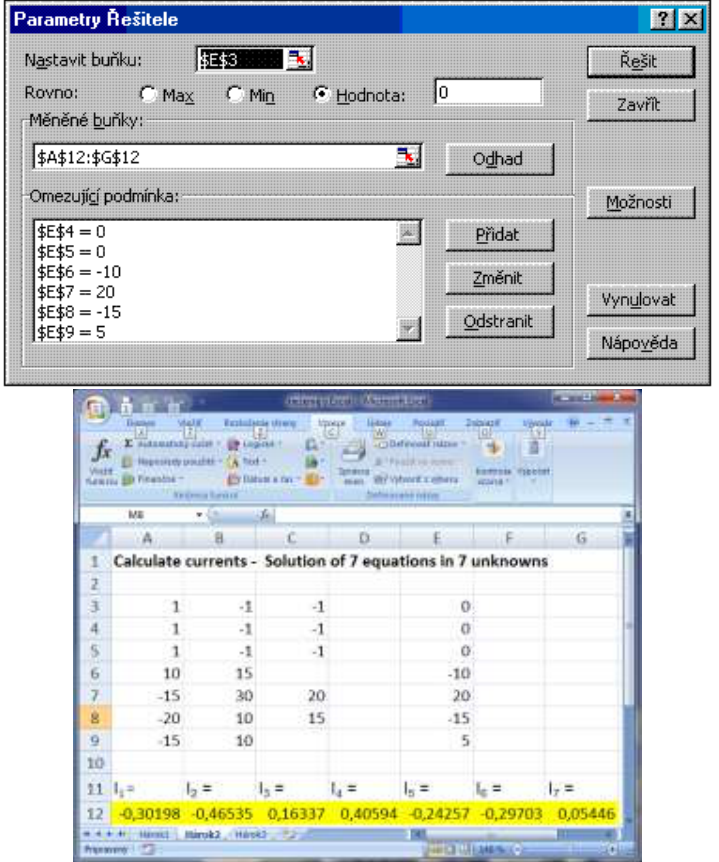
Fig. 3. Numerical solution of the system of problems in the MS Excel